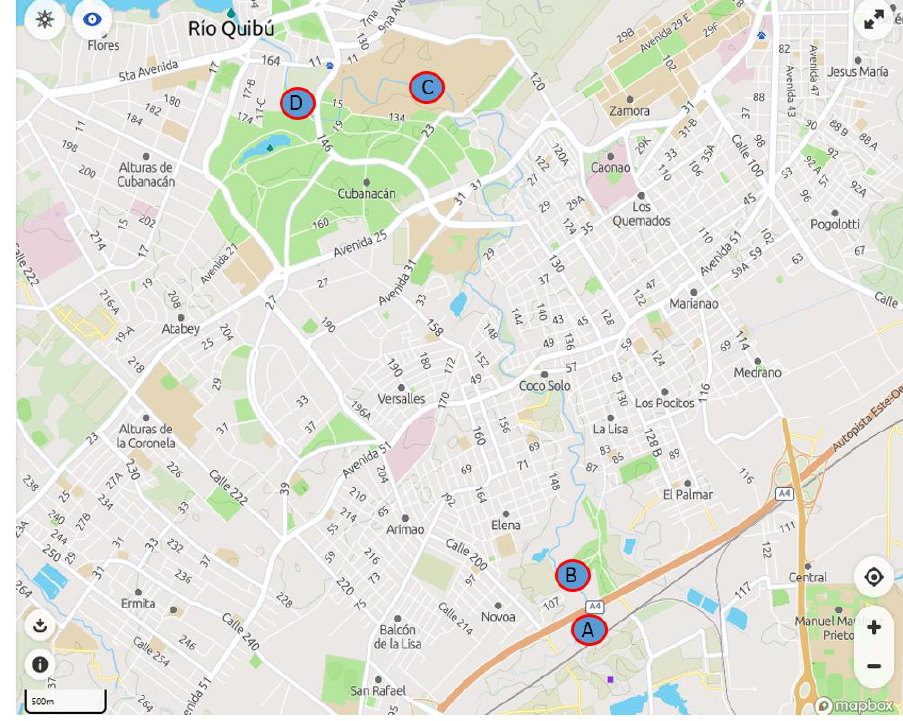
Figure 5 . Surface water sampling points in the Quibú river basin. Figure 5. Surface water sampling points in the Quib ú river basin. Table 5 . Analysis of Quibú river water samples. Table 5. Analysis of Quib ú river water